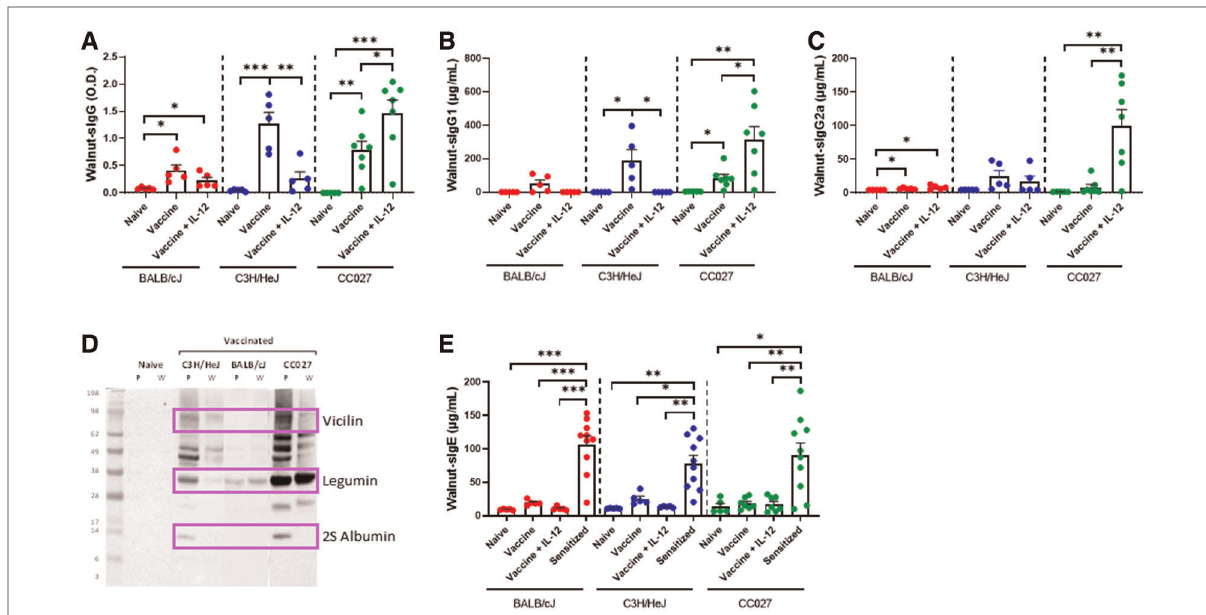
FIGURE 4 Walnut-speci fi c immunoglobulin responses following DNA vaccination with Gene Gun. Walnut-speci fi c ( A ) IgG, ( B ) IgG1, and ( C ) IgG2a in naïve and vaccinated BALB/cJ, C3H/HeJ and CC027 mice. ( D ) Western blot showing Gene Gun-vaccinated mice make walnut ( W )- and pecan ( P )-speci fi c IgG against the major allergens (purple boxes): vicilin (Jug r 2 and Car i 2), legumin (Jug r 4 and Car i 4), and 2S albumin (Car i 1). ( E ) Walnut-speci fi c IgE in naïve, vaccinated and sensitized BALB/cJ, C3H/HeJ, and CC027 mice. Statistical comparisons were made using unpaired t tests; * p <0.05, ** p <0.01, *** p <0.001.